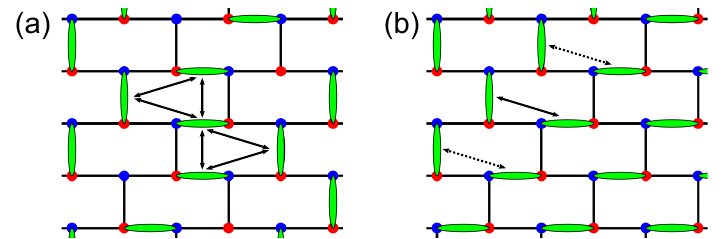
Figure 24: Dimer-dimer interactions on the brick (honeycomb) lattice. Dimers interact if they are on the same hexagonal plaquette and are separated by a single unfilled bond, and interactions are shown by black arrows. Each interaction carries a weight z in the partition function Z hon2 [ Eq. 72 ] . The 2 system can be split into connected clusters of mutually interacting dimers, and these are only assigned the correct weight when the expansion of the action reaches that of the cluster size (see Eq. 73). (a) The [ a , b ] . largest connected cluster has 5 dimers, and it is therefore necessary to consider terms up to S 10 (b) The largest connected cluster has only 2 dimers, and the weight is correctly assigned by considering [ a , b ] terms up to S 4